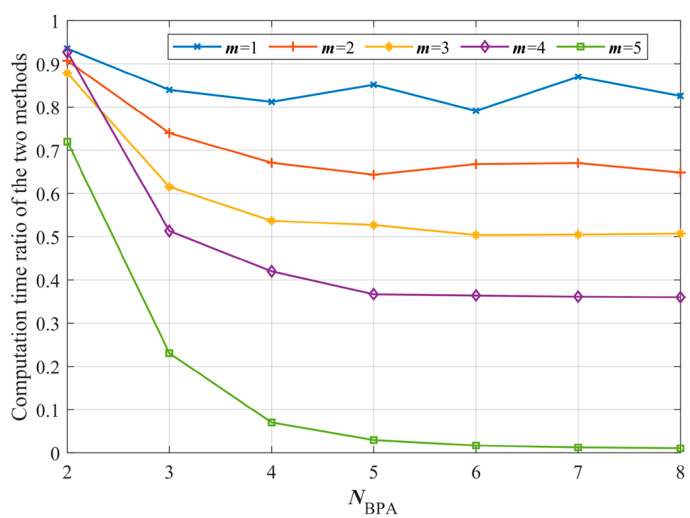
Figure 6. Computation time ratio of the SSR-ETM to the ETM for the five-dimensional